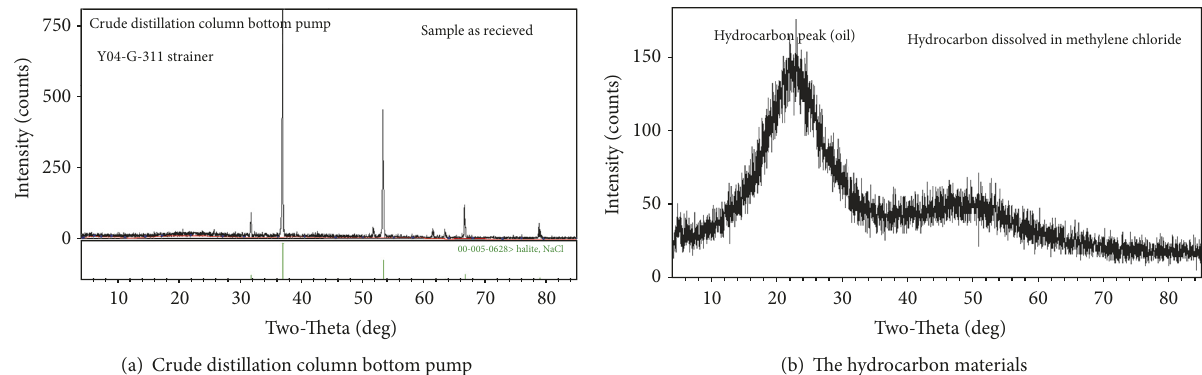
Figure 7: XRD phase identification results along with the standard reference mineral. (a) The as-received, crude distillation column bottom pump consists of halite [NaCl]; (b) the sludge, which shows the hydrocarbon peak. Here hydrocarbon is dissolved in methylene chloride.